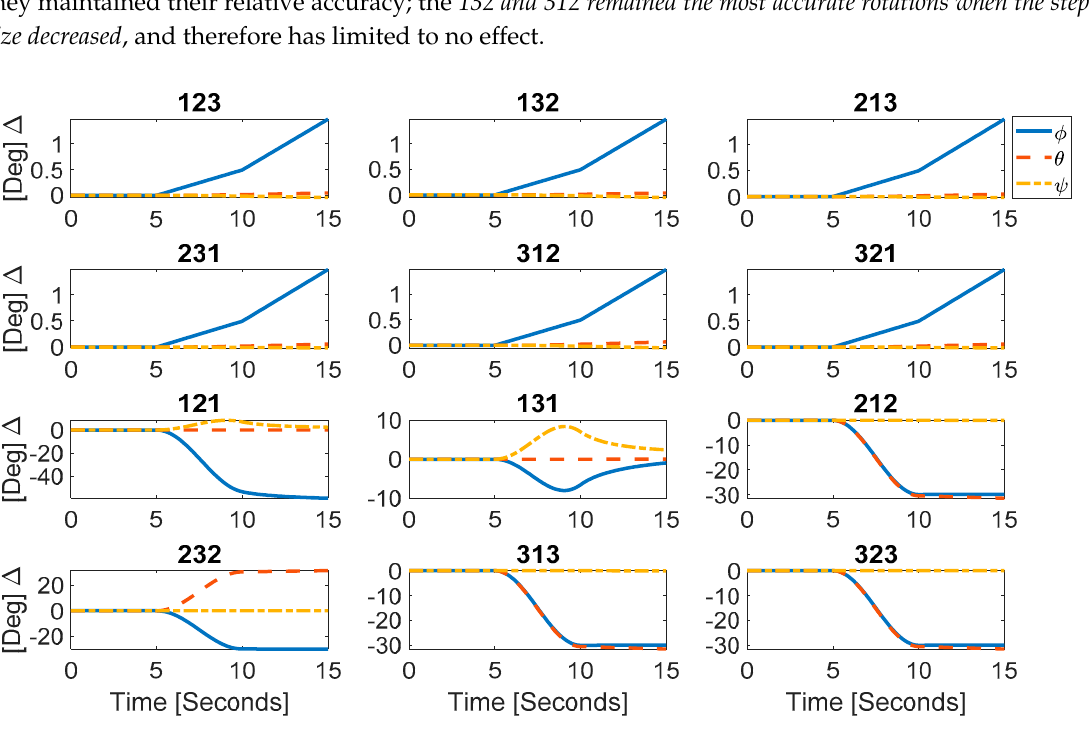
Figure 3. Corrected Euler Angles vs time for all 12 DCM rotations.